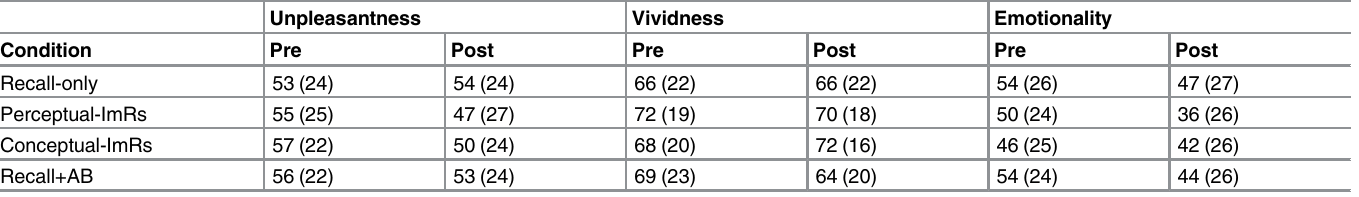
Table 1. Means (SD) of unpleasantness, vividness, and emotionality of the aversive autobiographical memory at pre- and post-measurement (in mm) per condition.